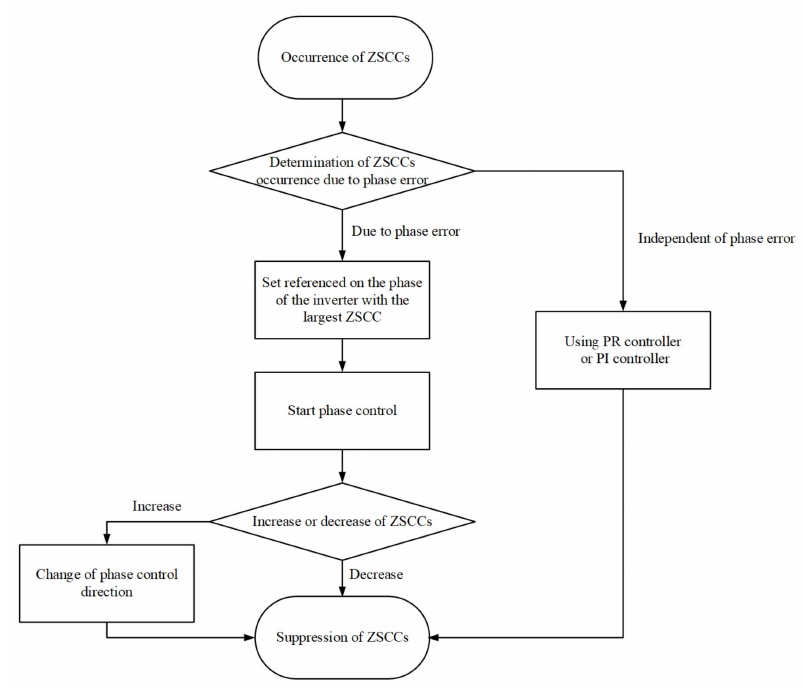
Figure 7. Control flowchart for the proposed carrier error compensation